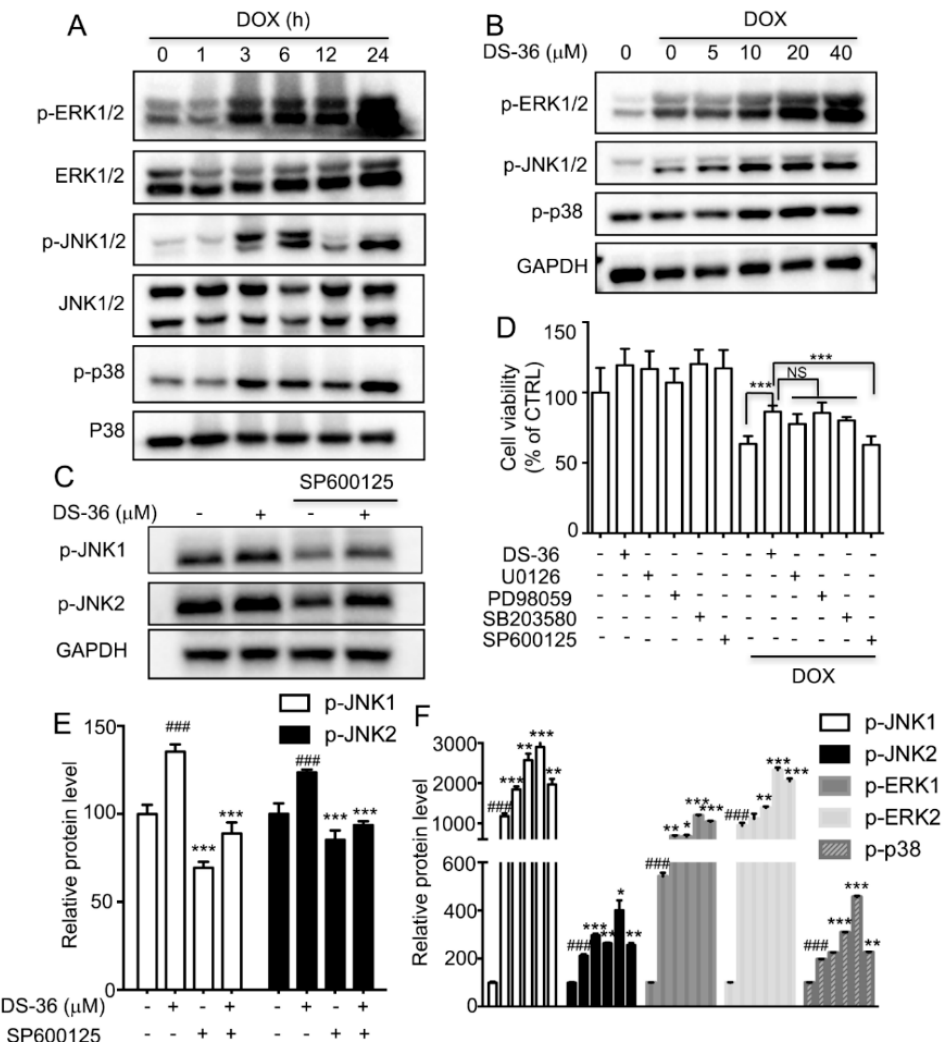
Figure 6. Effects of JNK 1/2 signaling pathway on the protective effect of DB against